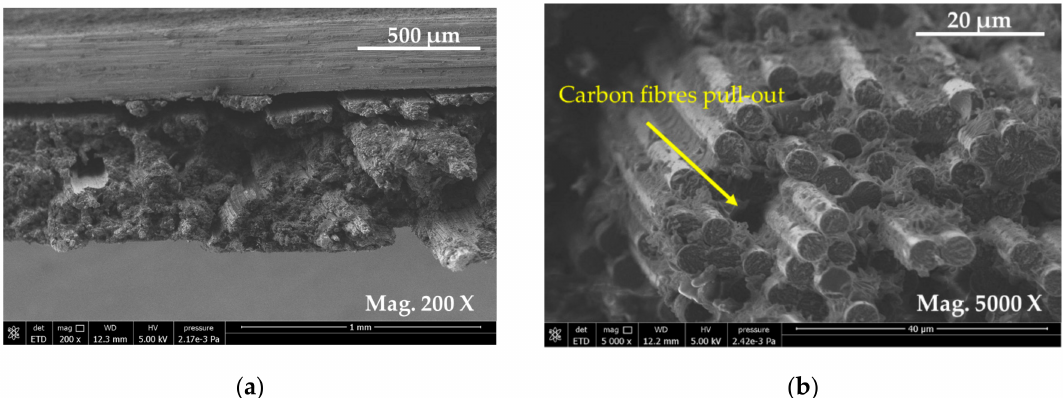
Figure 9. E-SEM micrographs of fractured surfaces of plain carbon fibre composites: ( a ) image showing carbon fibre aligned on the top at 0 / 90-degree orientation magnified view of carbon fibres observed aligned, and ( b ) magnified images of carbon fibres showing fracture in perpendicular direction of the applied load where fibre pull-out was